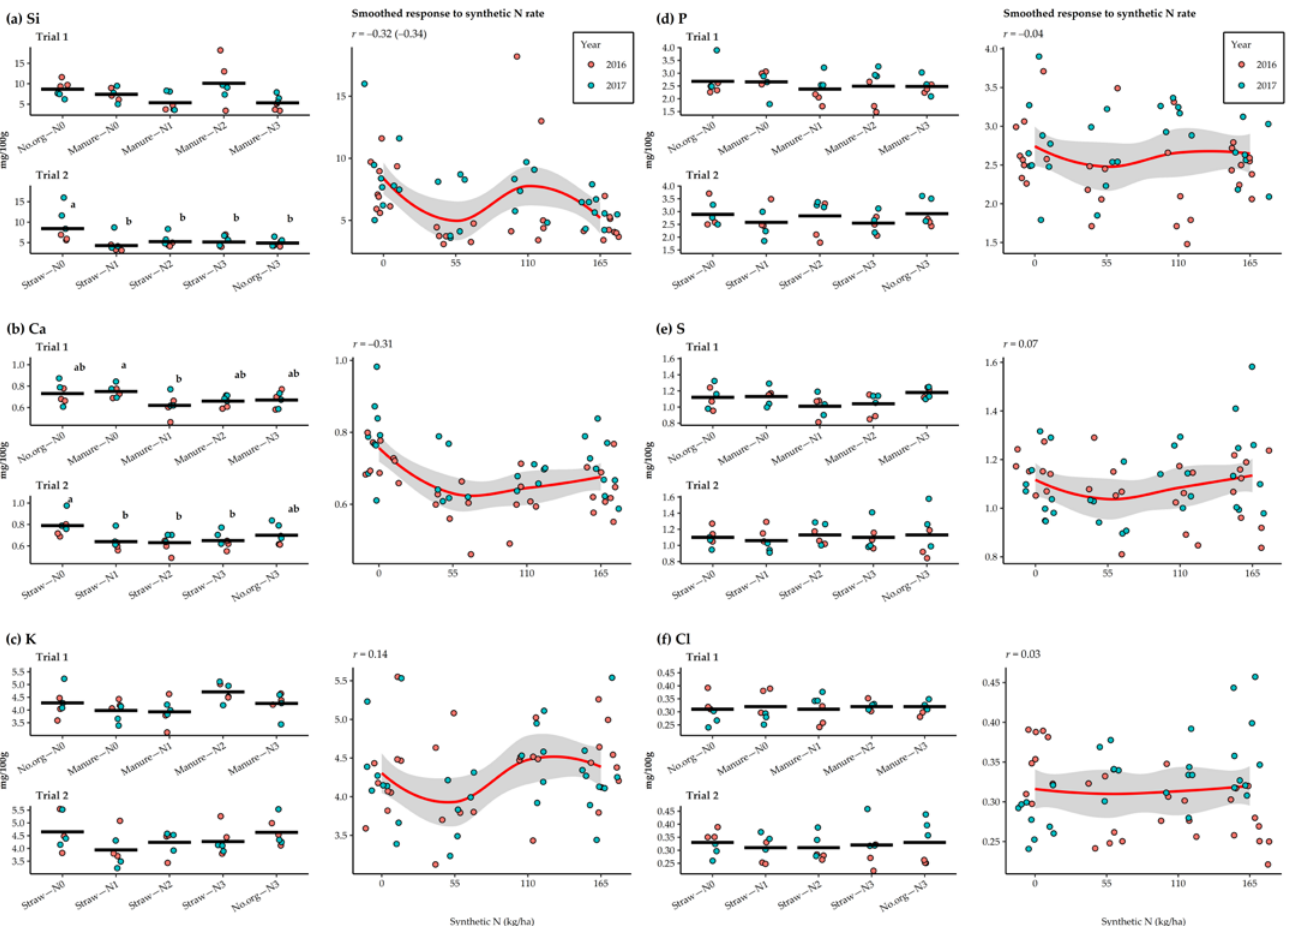
Figure 2. Response of macroelements ( a – f ) in oat grains to N rates and agronomic management practices applied in a long-term field experiment in 2016–2017. The crossbar indicates the mean value, while the dots represent individual observations. Means marked with different letters represent significant differences according to Tukey’s HSD test ( α = 0.05) within each trial. The smoothed conditional means method (Loes method) represents the overall observed response of the selected variables to the synthetic N rate and the correlation coefficient. When the data was transformed in both trials, the “ r ” value in brackets indicates the correlation coefficient for the transformed data.